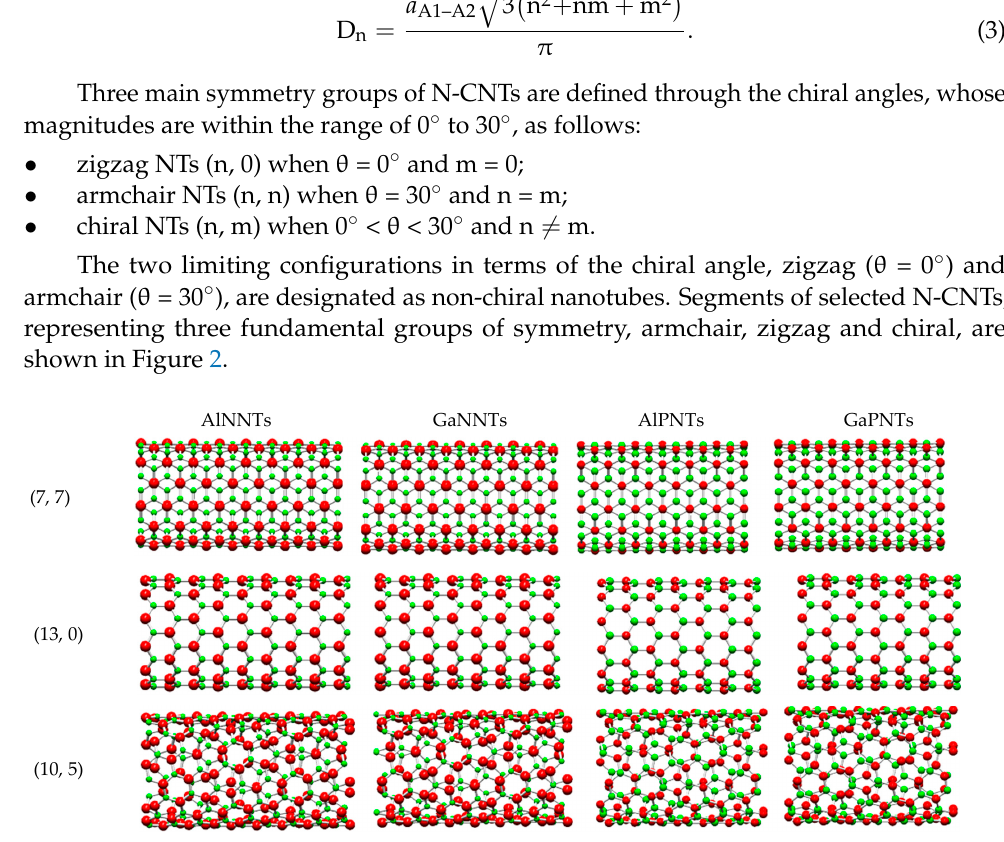
Table 1. Values of the bond length of hexagonal diatomic nanostructures available in the literature. Compound BN